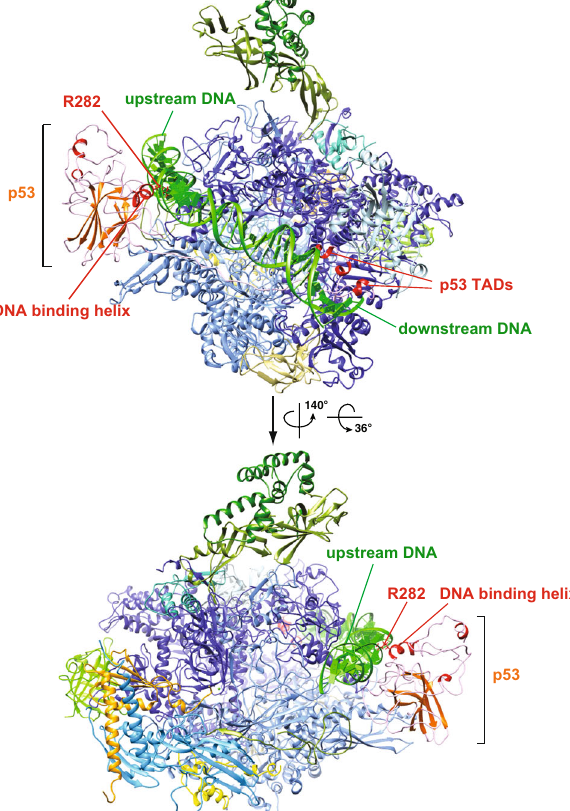
Fig. 5 Proposed model of the p53/Pol II cavity targeting DNA. A proposed model of the p53/Pol II cavity that interacts with DNA was generated via molecular dynamics simulation. The structure most frequently appearing during 20ns production runs is presented. The key DNA binding residue of p53, R282, is